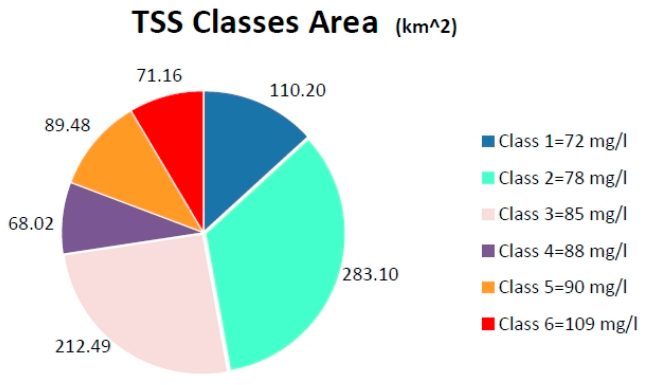
Figure 5 . The areas of the TSS concentrations classes. Figure 5. The areas of the TSS concentrations